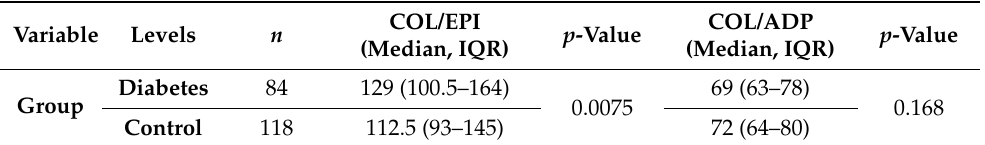
Table 2. Comparison of COL/EPI and COL/ADP CTs between neonates born to mothers with GDM and control group.